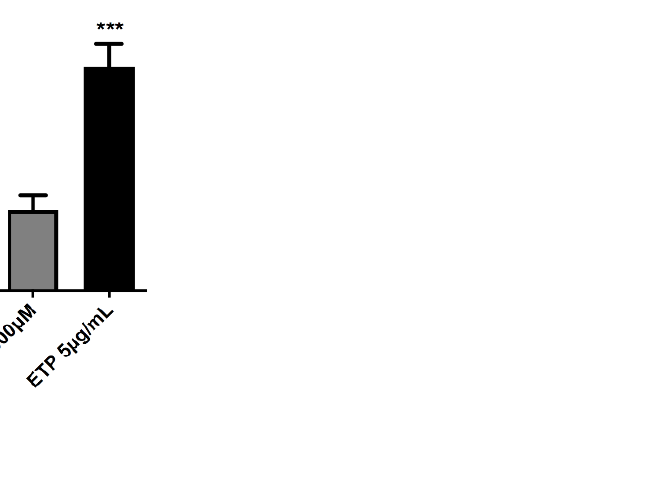
Figure 5. Apoptosis fold increase in TK6 cells after 26 h co-treatment with (±)cis- 4,4′ -DMAR and (±)trans- 4,4′ -DMAR or the positive control ETP at the indicated concentrations compared to the concurrent negative control [0 µM]. Each bar represents the mean ± SEM of three independent experiments. Data were analysed using one-way repeated measures ANOVA followed by Bonferroni as post-test. *** p < 0.001 vs . [0 µM].